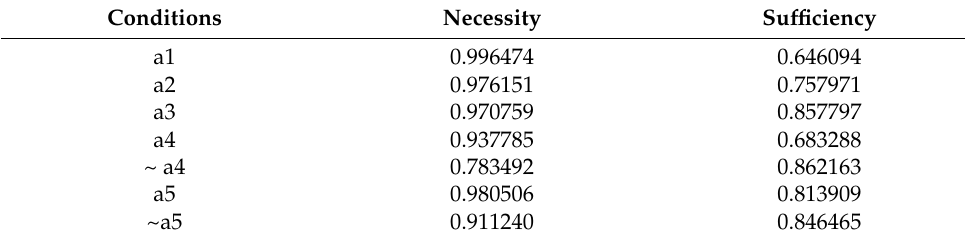
Table A15. Necessity and sufficiency analysis of conditions (ultimate